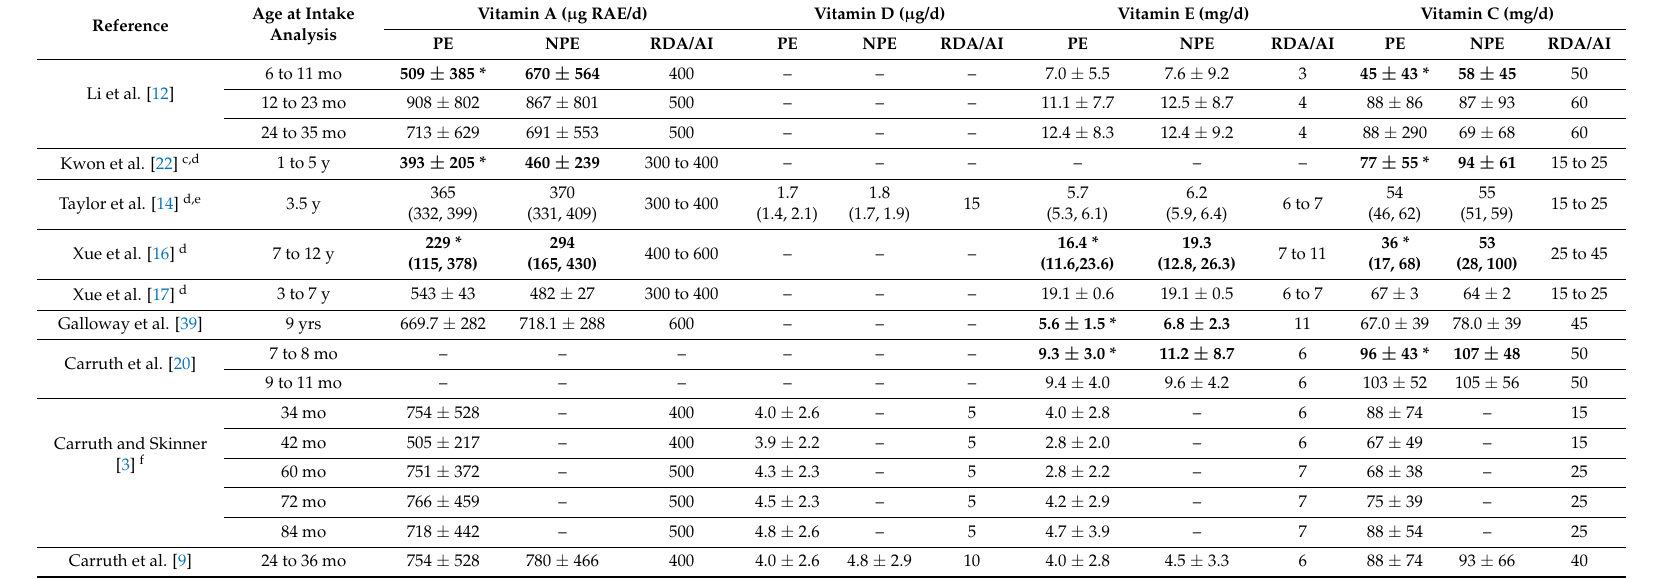
Table 6. Intakes of Vitamins A, D, E and C in PE and NPE a,b